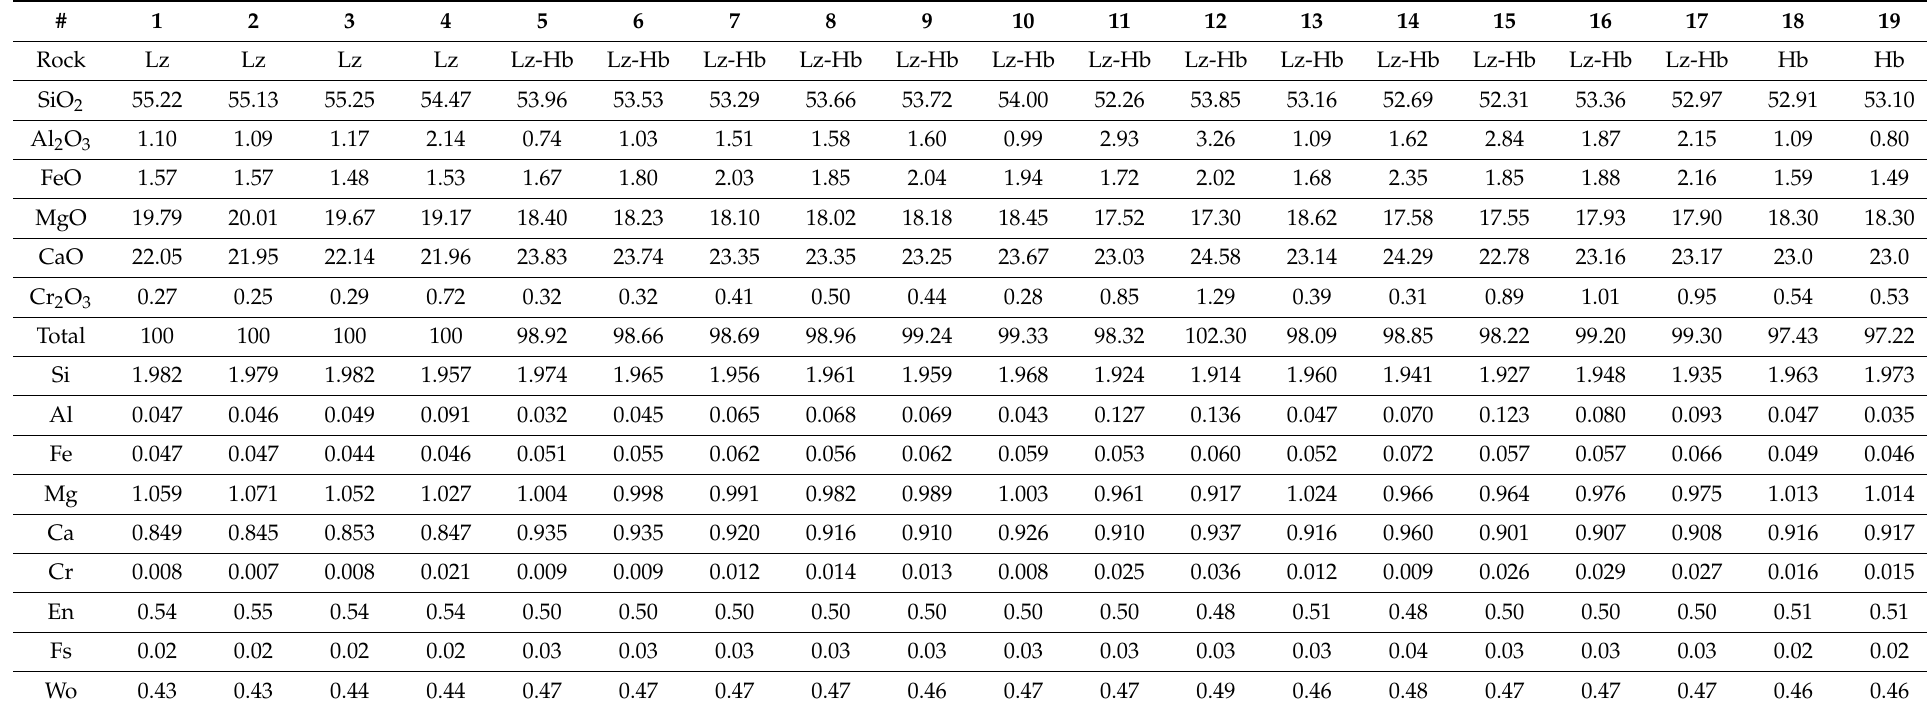
Table 4. Composition of clinopyroxene grains in peridotite of Kempirsay massif